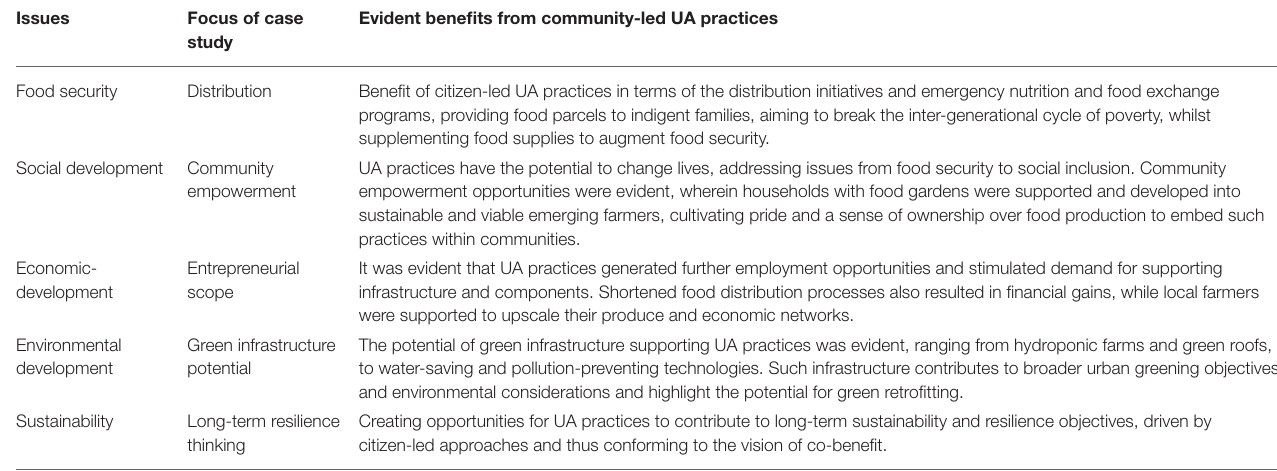
TABLE 3 | Broader spin-offs relating to the UA initiatives in